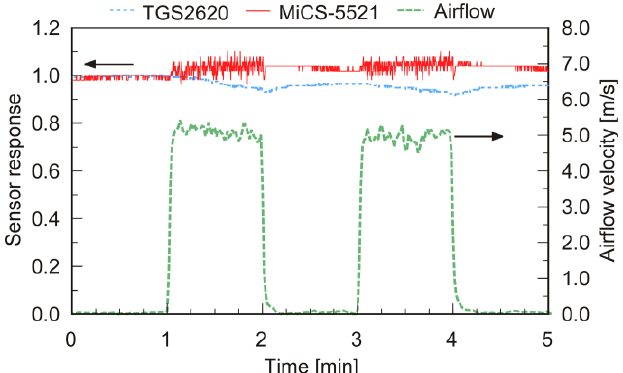
Figure 4. Changes in the response values of two metal oxide gas sensors against airflow. The two gas sensors were placed 0.5 m from an electric fan and exposed to airflow of 5 m/s.